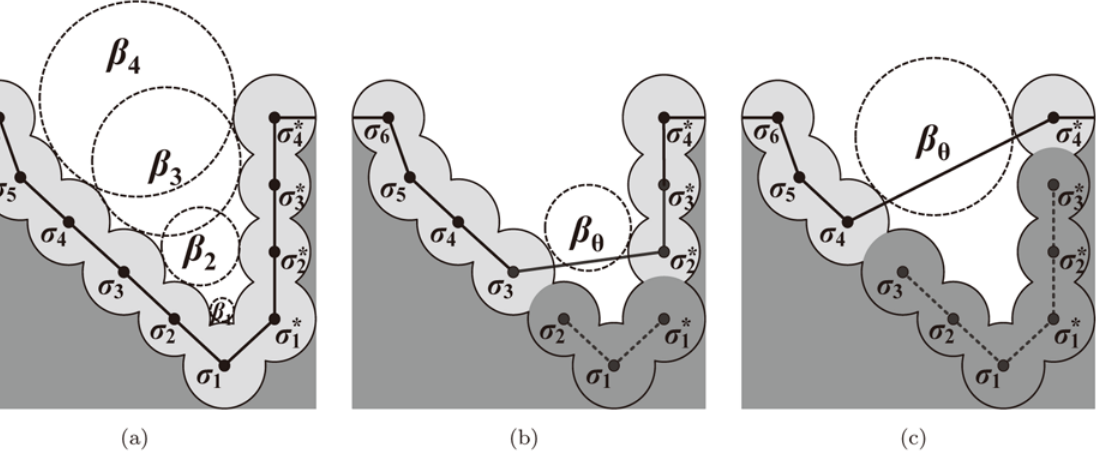
Fig 2. The idea of pocket recognition using the beta-shape. (a) Empty tangent balls defining the exposure intervals of each atom on the boundary. (b) The pocket { σ 1 , σ 2 , s (cid:1) 1 } where β 2 < β θ (cid:3) β 3 . (c) The pocket { σ 1 , σ 2 , σ 3 , s (cid:1) 1 , s (cid:1) 2 , s (cid:1) 3 } where β 3 < β θ (cid:3) β 4